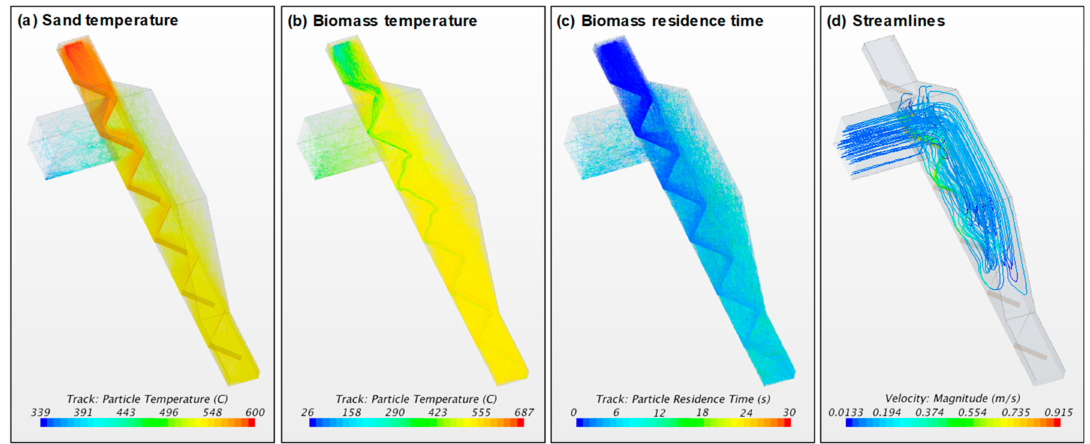
Figure 7. Particle behaviors and streamlines at the reactor temperature of 554 ◦